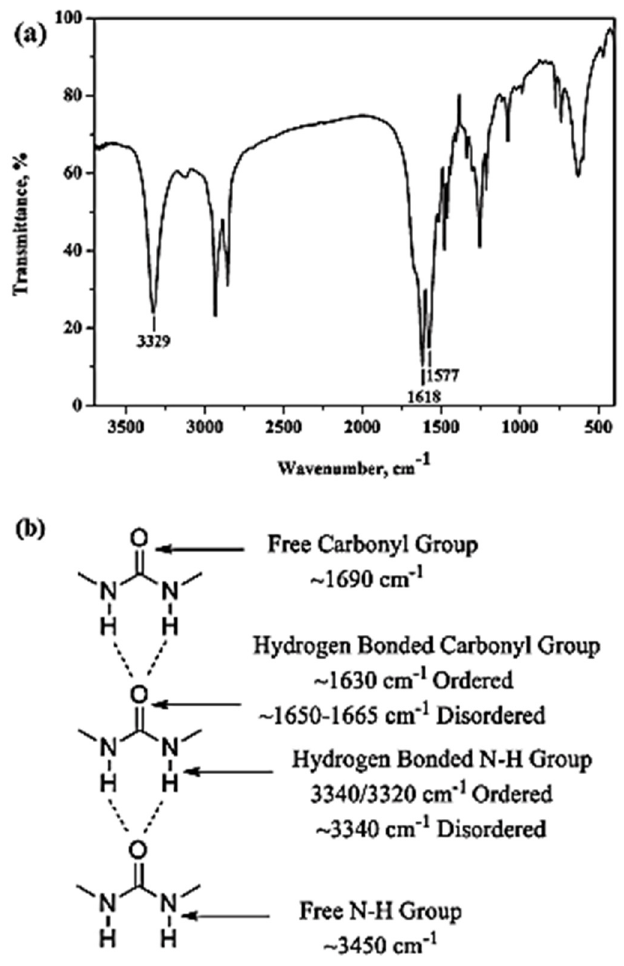
Figure 17. ( a ) The FTIR spectrum of the solid product of the reaction of HDA with CO 2 . ( b ) Band assignments for the polyurea carbonyl and N-H stretching modes. From reference [48].